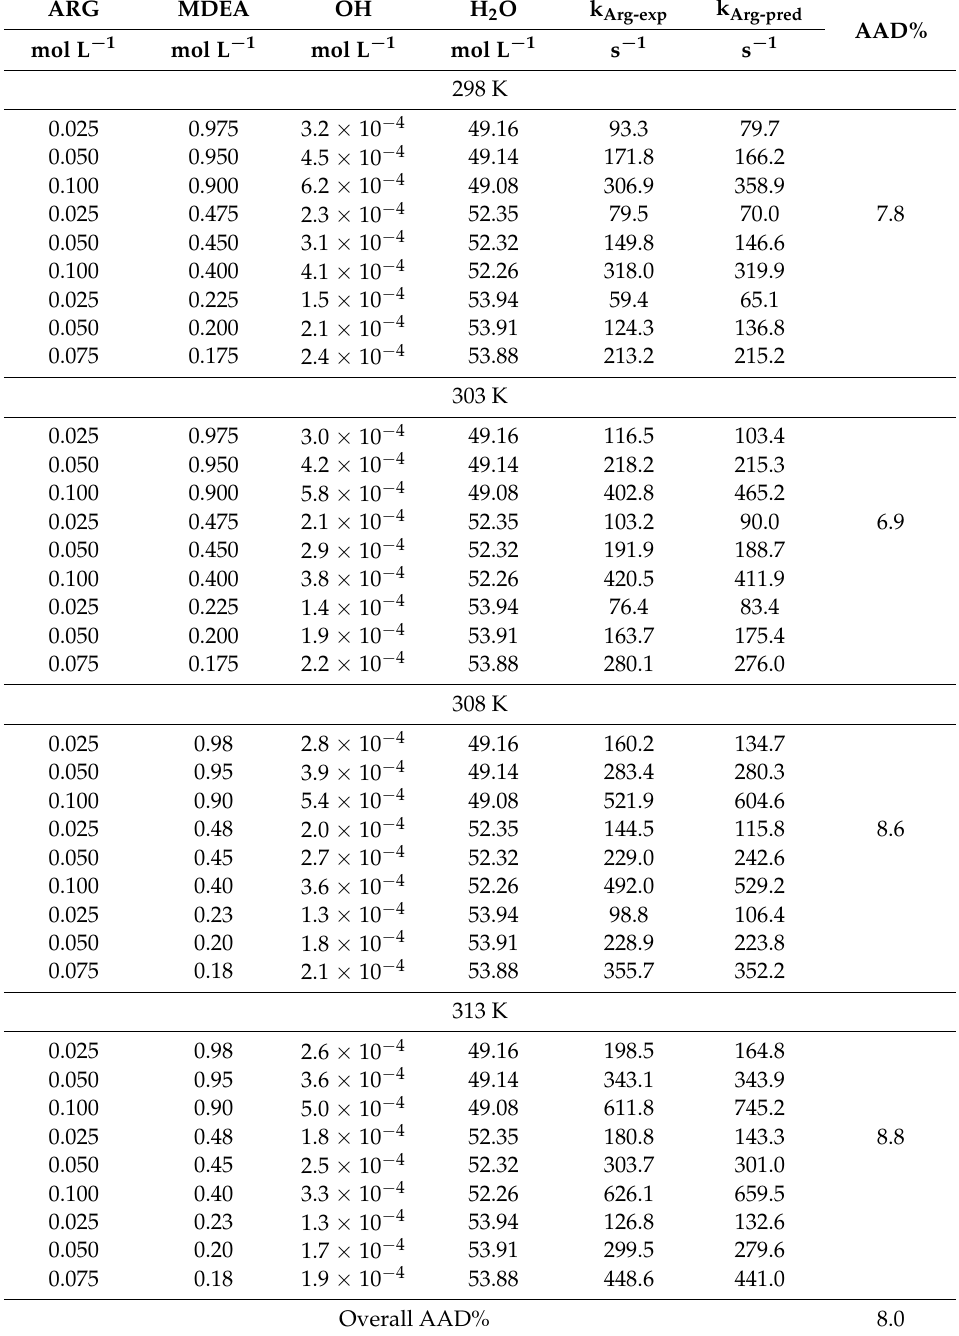
Table 7. Rate constants at different temperatures and (MDEA+Arg) concentrations.